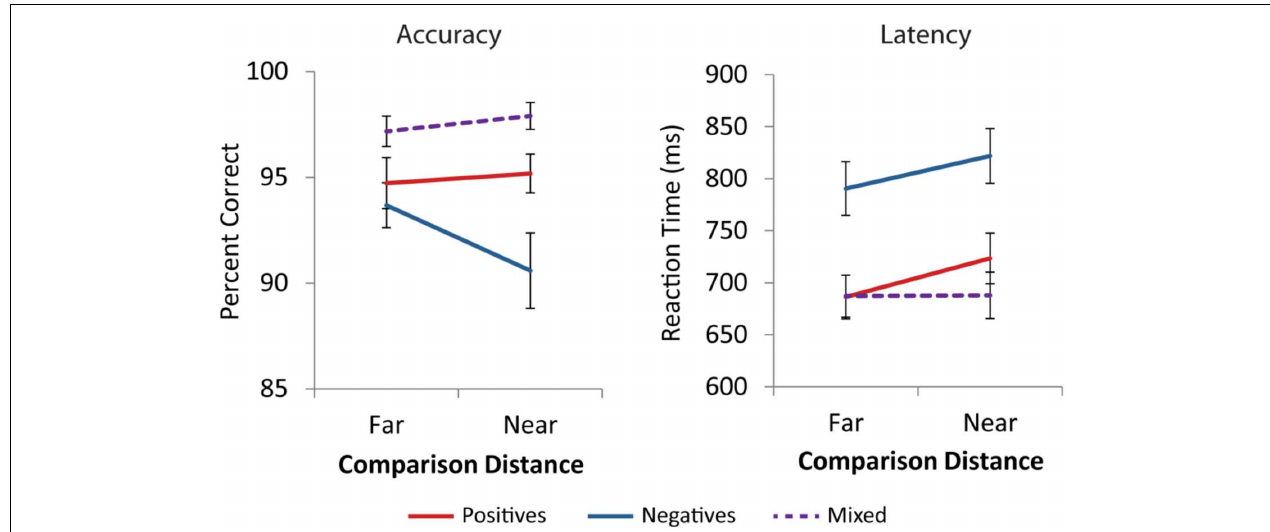
FIGUREA1 | Behavioral performance. Participants were significantly faster and more accurate on mixed comparisons than positive and negative comparisons ( p < 0.001). Mixed comparisons did not display distance effects in accuracy ( p = 0.304) or reaction time ( p = 0.890). Error bars represent ± 1